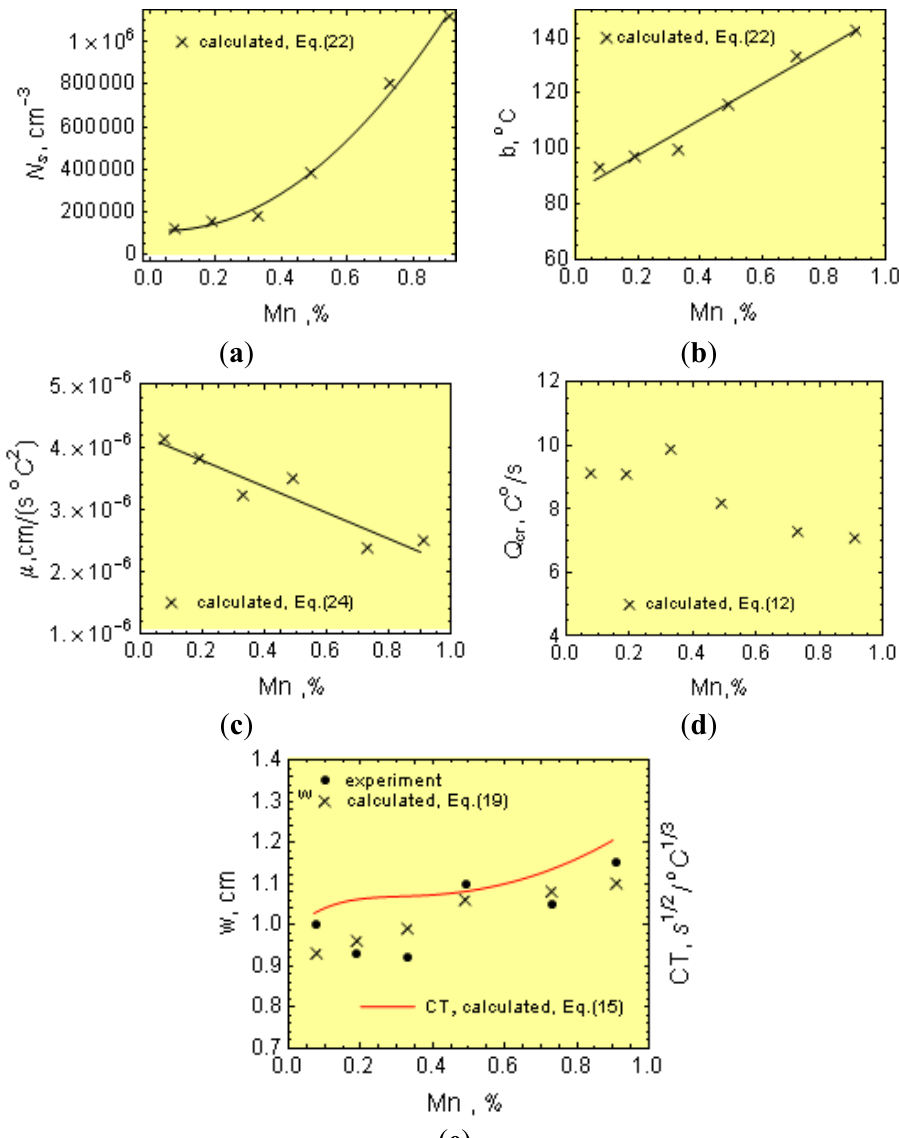
Figure 17. Effect of manganese on ( a ) N s , ( b ) b , ( c ) μ, ( d ) CT index and ( e ) w.